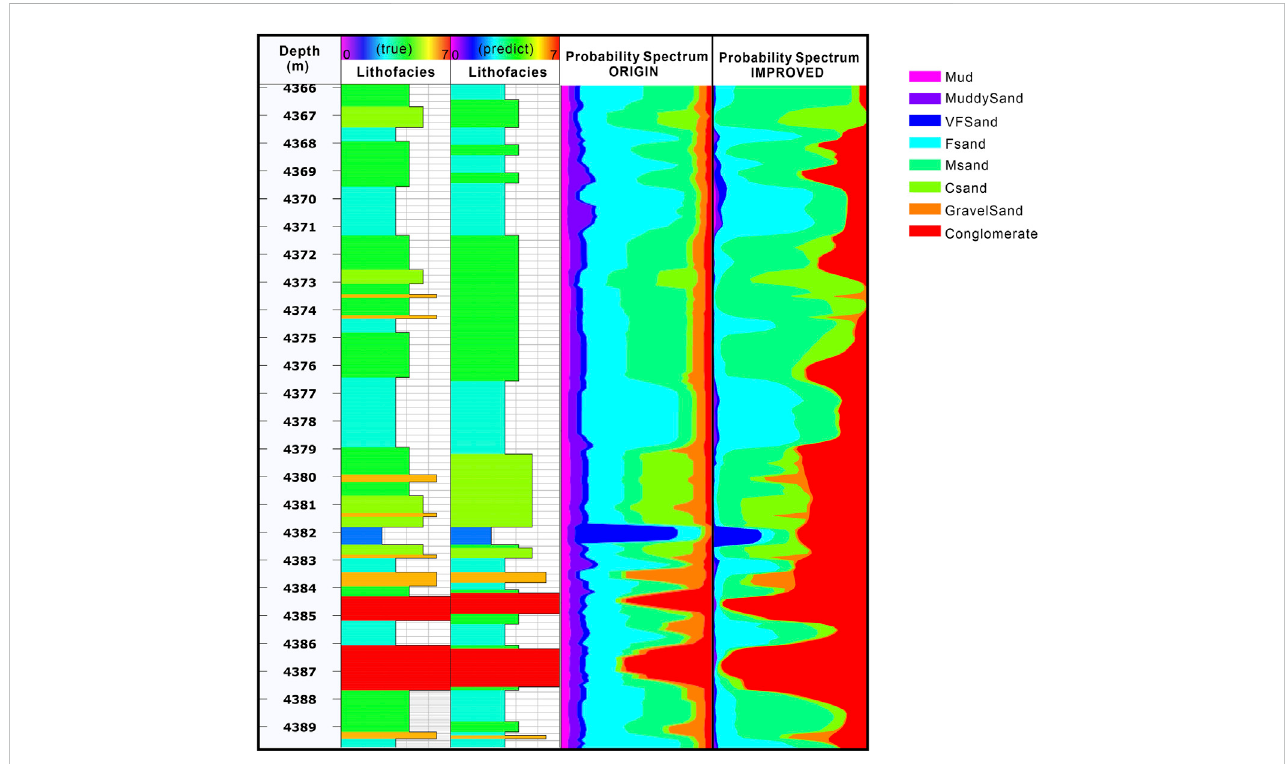
FIGURE 14 Comparisonofcoretaggingprobabilityspectra(takingtheChuang105wellasanexample).ORIGINmeansnosamplingwasperformedandthepriorand likelihoodwerecalculatedusingtheMCMCmethod.IMPROCVEDrepresentsthatMarkovchainswereusedtocalculate apriori posteriorandtoimprovedata imbalance using the SMOTE method.